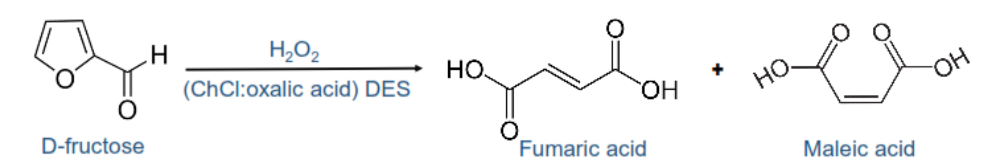
Figure 16. The reaction scheme for conversion of furfural to fumaric acid and maleic acid [12].